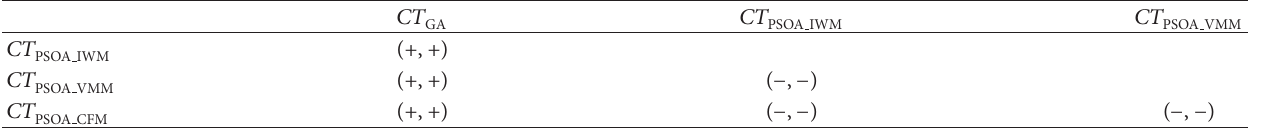
Table 11: Multiple comparison on convergence time.